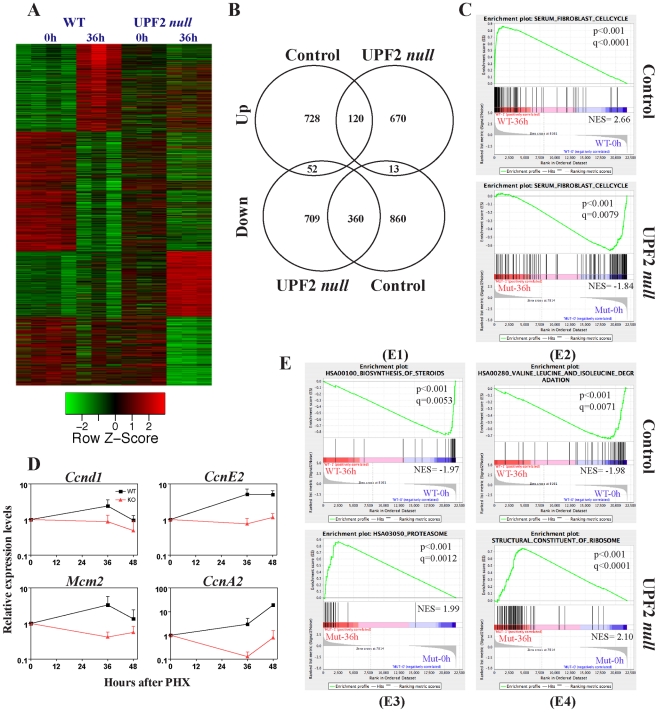
Gene expression analysis of UPF2 null adult livers following PH.(A) Cluster analysis of normalized affymetrix expression data from control and UPF2 null adult livers before (0 h) or after (36 h) PH. Venn diagrams of differentially expressed probesets following PH. The diagrams reveals the induction of partially overlapping gene expression programs in control and UPF2 null adult livers following PH. (C) GSEA reveals that gene sets involved in cell cycle regulation are differentially induced in control and UPF2 null adult liver following PH. (D) qRT-PCR validation of 4 cell cycle regulated and PH-induced genes. cDNA was synthesized from 3 mice of each genotype at each timepoint and assayed by qPCR in triplicates (mean +/− standard deviation). (E) Selected enriched gene sets from GSEA analysis of differentially expressed genes following PH in control and UPF2 null livers. E1: HSA00100_Biosynthesis_of_Steroids, E2: HSA00280_Valine_and_Isoleucine_degradation, E3: HSA03050_Proteasome, E4: Structural_Constituent_of_ribosome. Normalized enrichment scores, P-value and q-values (FDR) are indicated for each gene set. Negative and positive NES values indicate enrichment in control and UPF2 null adult livers, respectively. Y-axes indicate Enrichment scores (top) and Ranked list metric (bottom). Green lines indicate enrichment profile, black bars are hits (i.e. genes) and grey profiles are ranked metric score. Red and blue indicate positive and negative correlations, respectively, with the indicated gene sets.